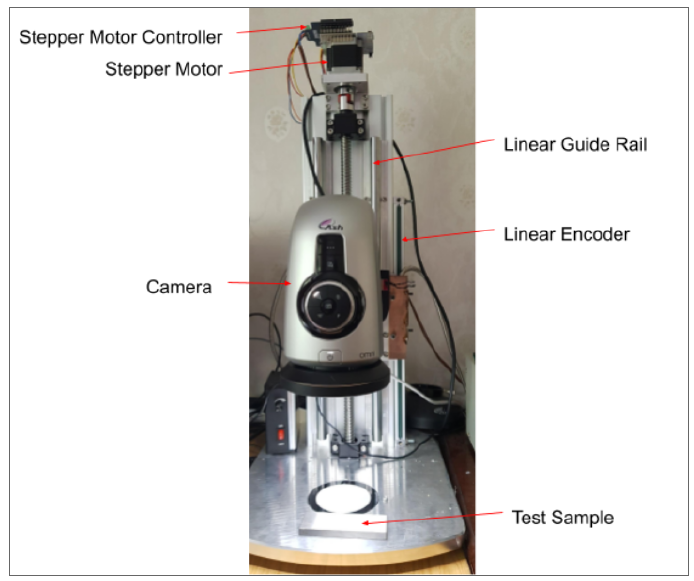
Figure 1. Camera calibration